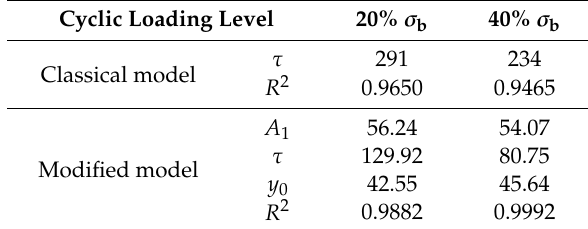
Table 3. Strength fitting equation coe ffi cient of GFRP bar for di ff erent